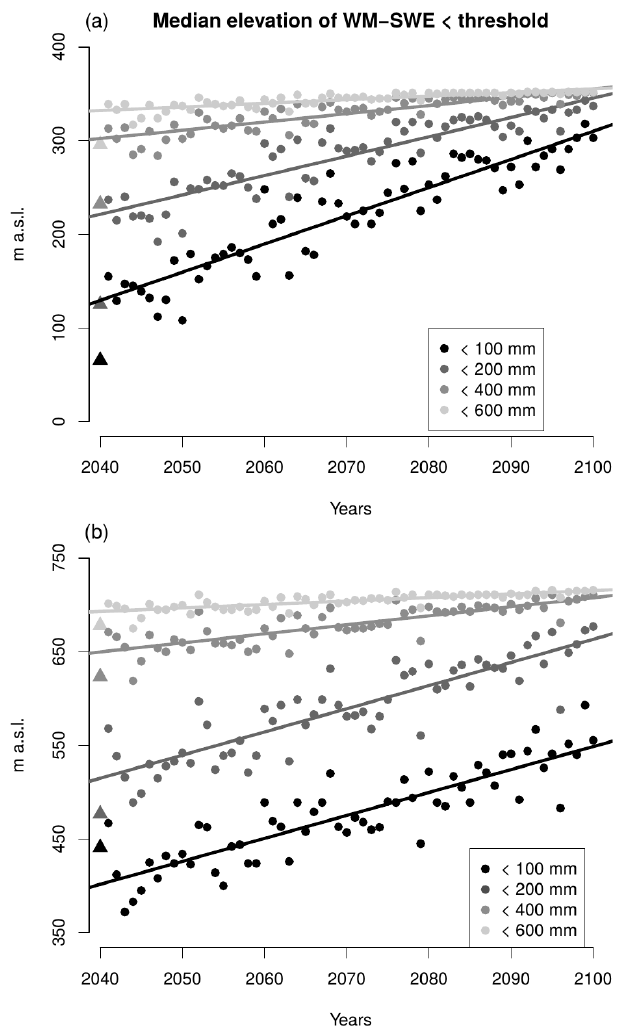
Figure 7. Projected future development in median elevation where winter maximum SWE is below 100mm (black), 200mm (dark grey), 400mm (medium grey) or 600mm (light grey). (a) Coast and (b) inland (see map in Fig. 1). Mean values for the period 1981– 2010 are indicated as triangles.